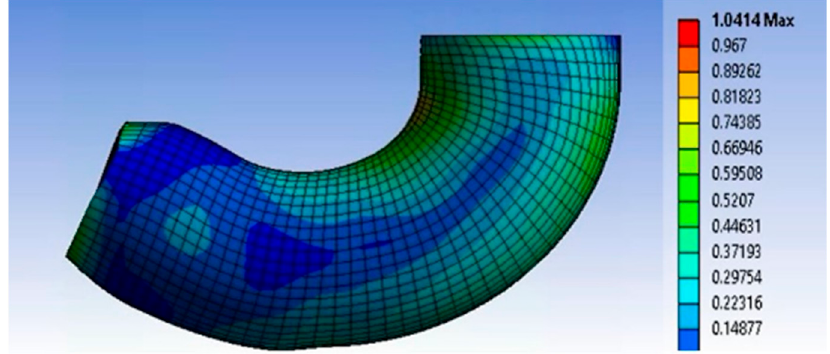
Figure 4. Simulation of effective strain distribution after processing through 1-P.